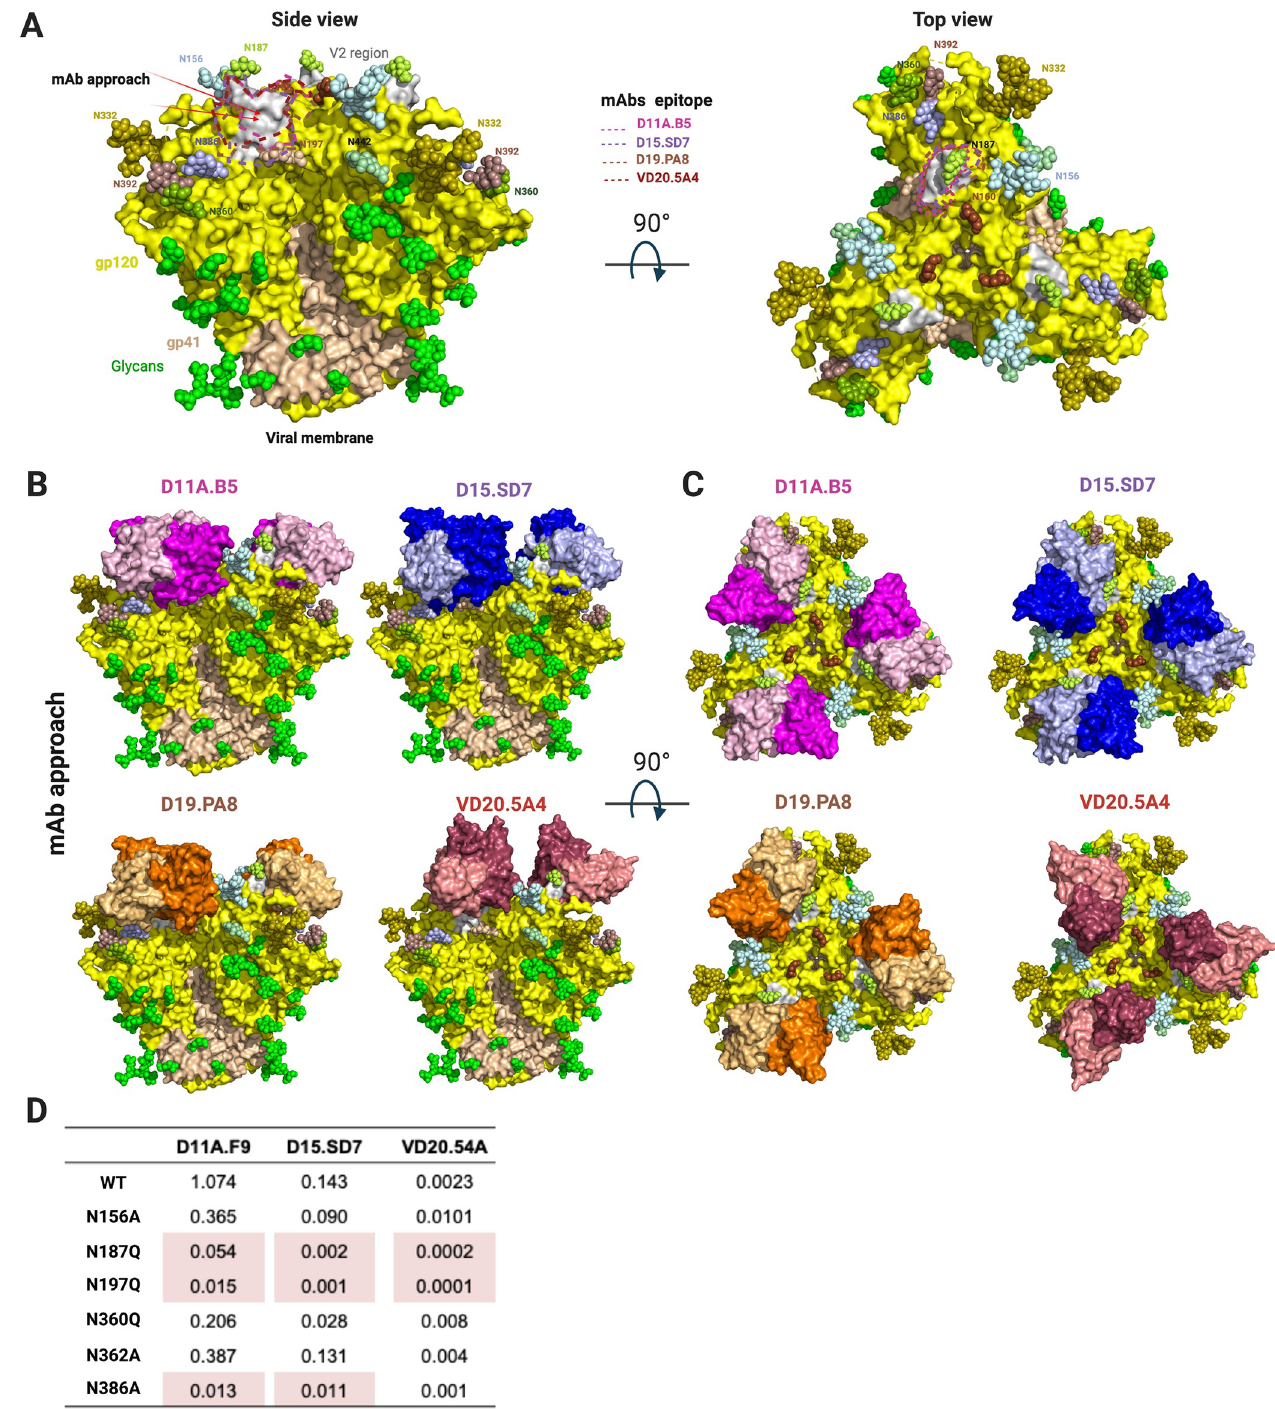
Fig 7. NHP Autologous tier 2 neutralizing antibodies target a hole in the HIV-1 glycan shield. ( A ) Side and top view surface representation of 16055 NFL (PDB:5UM8) with gp120 shown in yellow, V2 region in grey, gp41 in wheat and glycans shown in green spheres or color-coded and labeled. Arrows indicate mAbs’ angle of approach. Epitopes targeted by the NHP mAbs are highlighted. (B) Side view and (C) Top view s uperpositions of the structures of D11A.B5, D15.SD7, D19.PA8 and VD20.5A4 onto the 16055 NFL trimer, showing how they access the glycan hole. Trimer and mAbs are shown in surface representation. Trimer is color coded as in ( A ) and mAbs as in Fig 3. (D) Effect of glycan removal surrounding the epitope on neutralization potency. Neutralization IC 50 values ( μ g/ml) shown with > 10-fold differences highlighted in